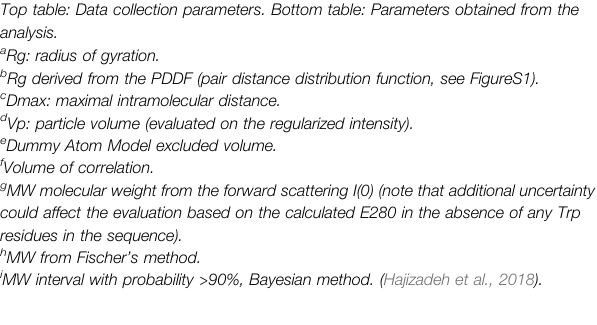
Top table: Data collection parameters. Bottom table: Parameters obtained from the analysis. a Rg: radius of gyration. b Rg derived from the PDDF (pair distance distribution function, see FigureS1). c Dmax: maximal intramolecular distance. d Vp: particle volume (evaluated on the regularized intensity). e Dummy Atom Model excluded volume. f Volume of correlation. g MW molecular weight from the forward scattering I(0) (note that additional uncertainty could affect the evaluation based on the calculated E280 in the absence of any Trp residues in the sequence). h MW from Fischer ’ s